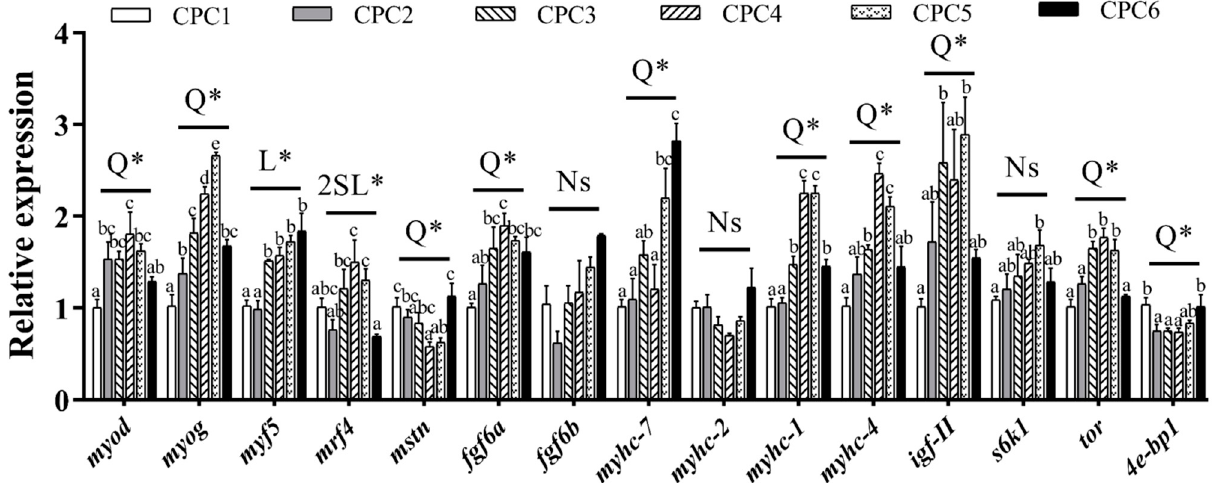
Figure 6. Muscle-related genes expression of grass carp fed with different protein levels for eight